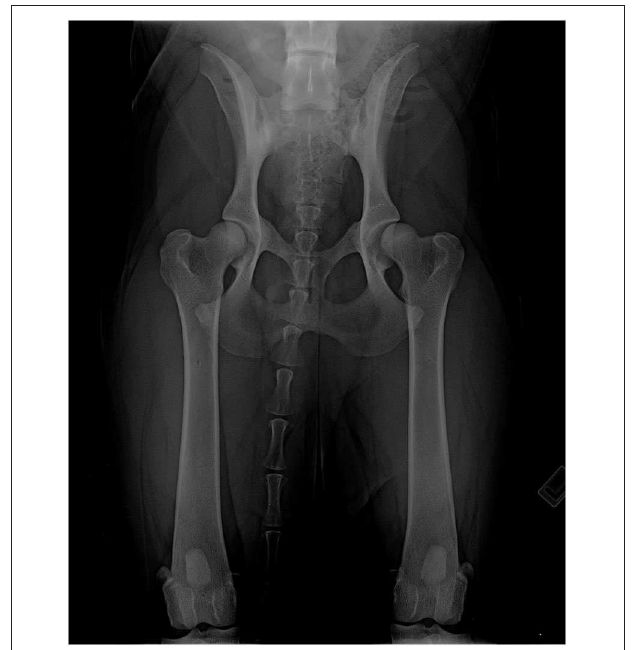
FIGURE 2 | Hands-free ventrodorsal hip extended radiograph of an Estrela mountain dog, female.